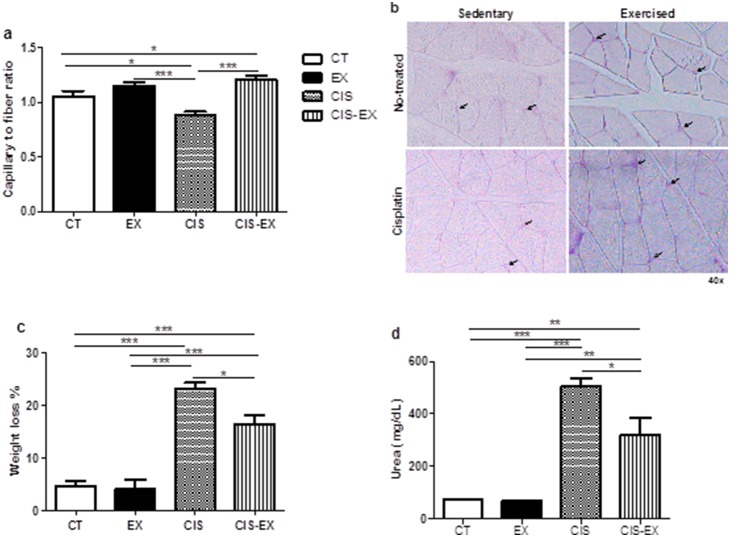
Aerobic exercise minimizes cisplatin-induced cachexia and renal damage.Exercise efficacy was confirmed by an increase in muscle angiogenesis in the exercised (EX) and exercised with cisplatin injection (CIS-EX) groups (A and B). Decreased weight loss (C) and lower levels of serum urea (D) in the CIS-EX group compared to the sedentary goup injected with cisplatin (CIS) indicate the protective effect of exercise. The sedentary group without cisplatin injection was used as the control (CT). *P<0.05; **P<0.01; ***P<0.001.